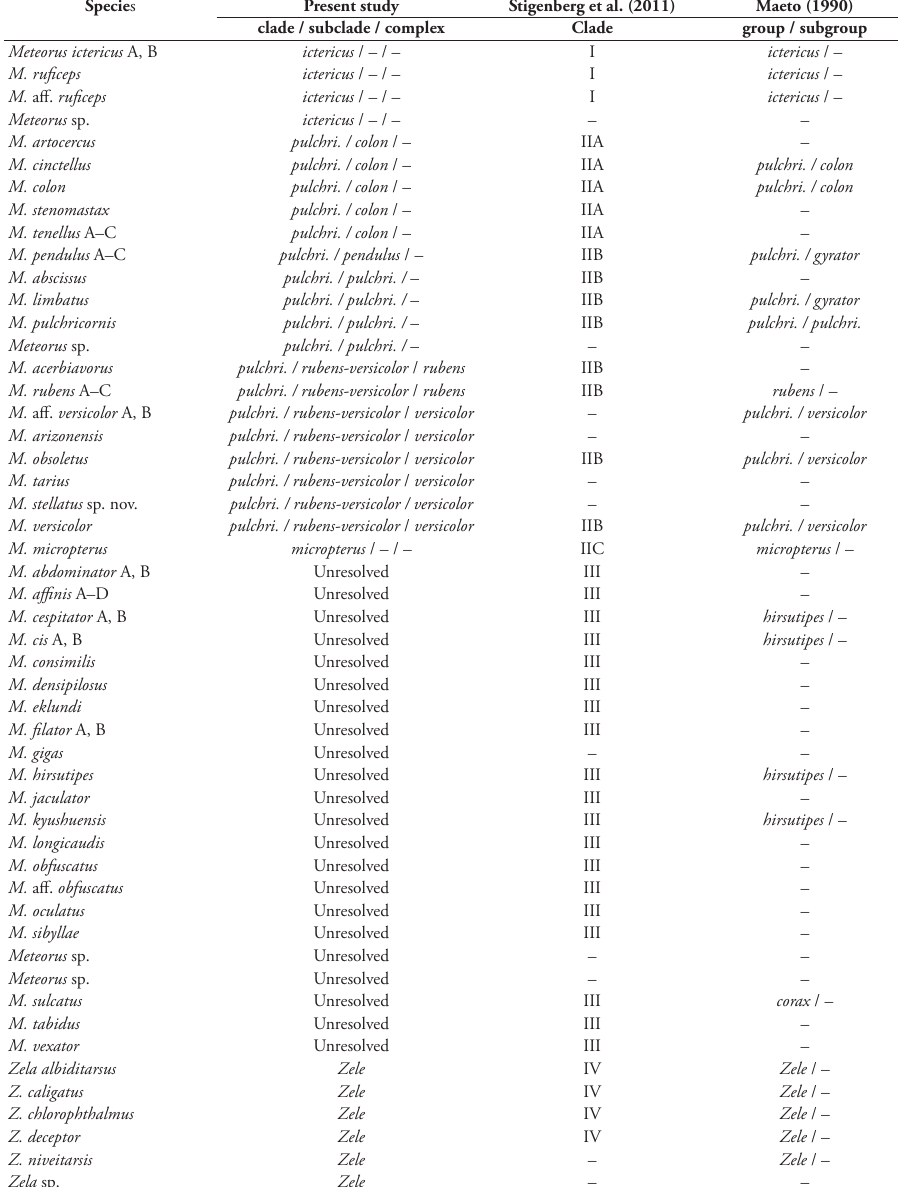
Table 3. Nomenclature systems for Meteorini species. The following abbreviations are used: pulchri . = pulchricornis